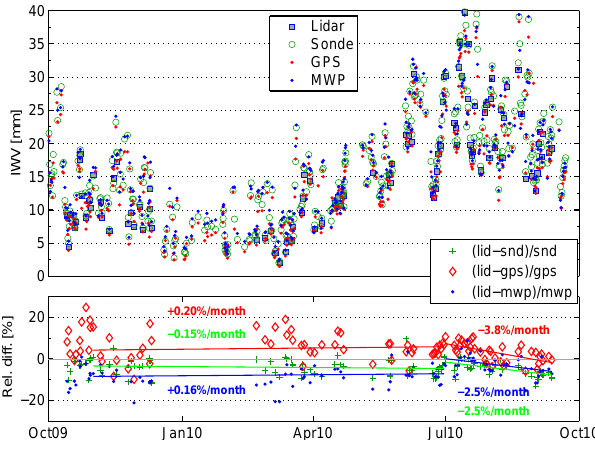
Fig. 10. Top panel: Integrated Water Vapor (IWV) time-series above Payerne retrieved from radiosondes, GPS, microwave radiometer and lidar (for the lidar, only profiles reaching at least 8 km are used, which correspond mostly to clear-sky and night conditions). Bottom panel: Relative difference between lidar and radiosondes (green crosses), between lidar and GPS (red diamonds), and between lidar and microwave radiometer (blue dots). For example, -10% means that lidar is 10% drier than reference. Generally, the lidar is drier than the radiosondes and more humid than GPS. Trends for the period November 2009 to June 2010 and for the period July to September 2010 have been added for information.